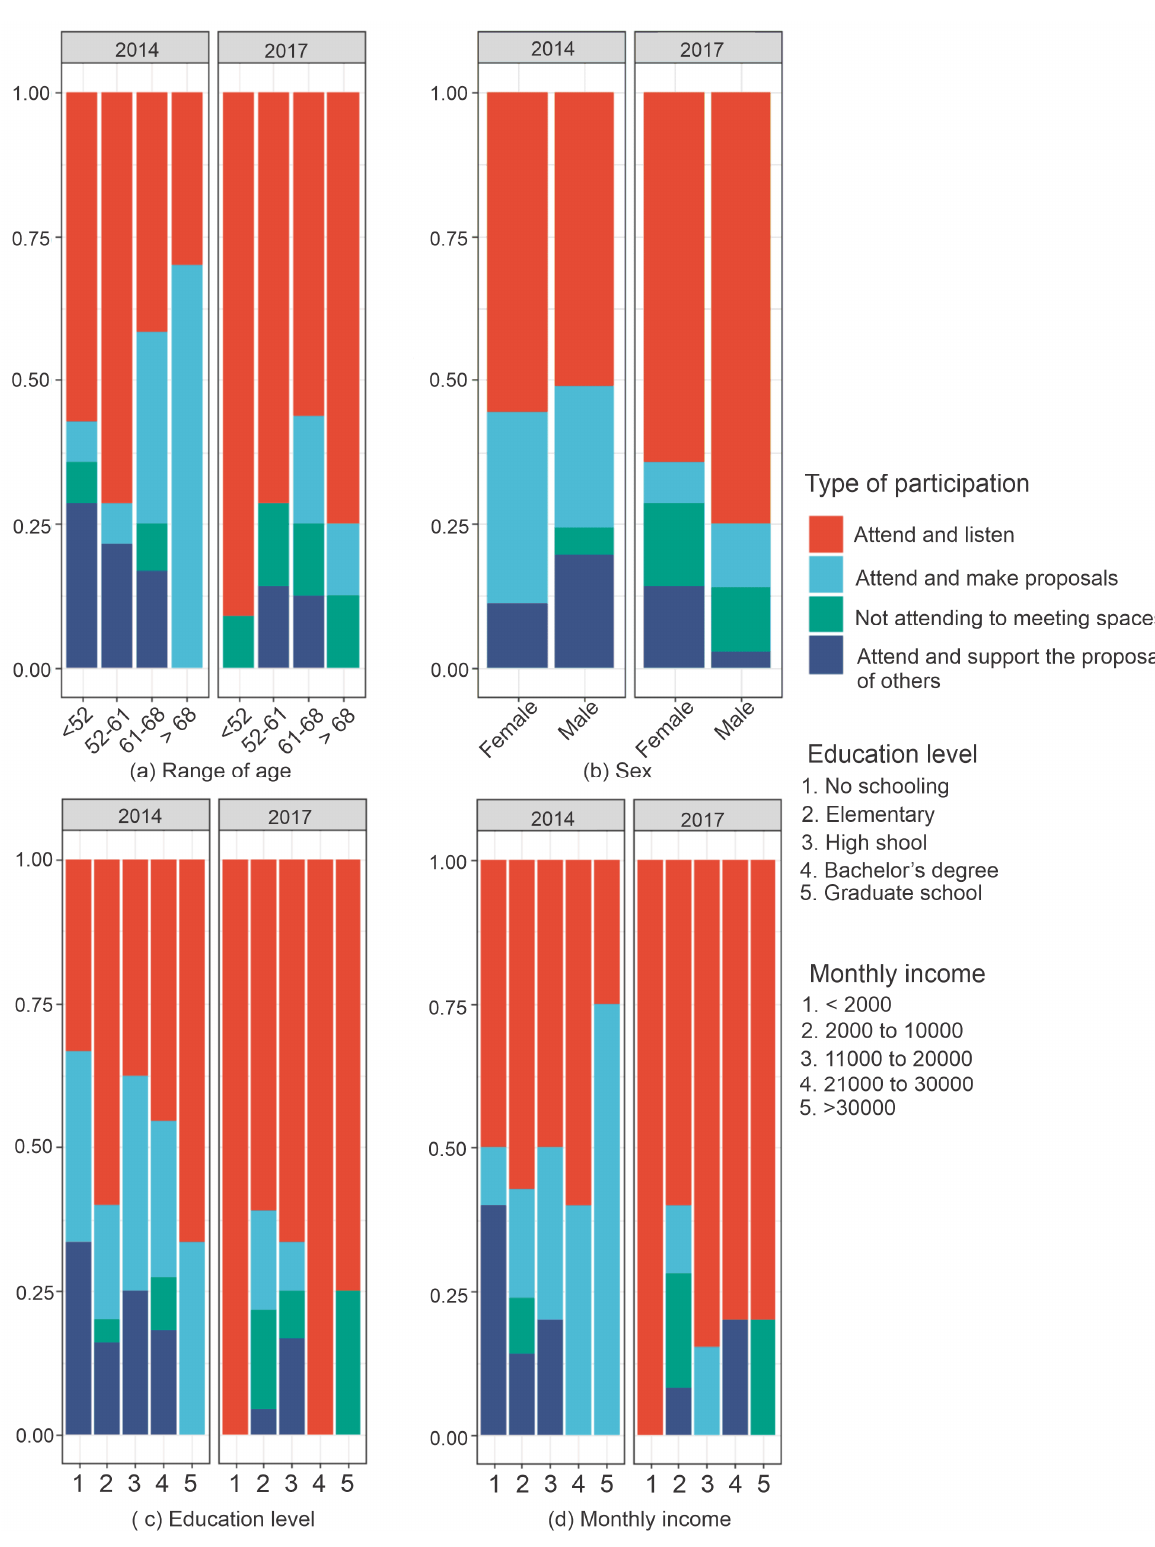
Figure 3. Types of participation by socioeconomic characteristics and survey application period: ( a ) fractions of responses by range of age; ( b ) fraction of responses by gender; ( c ) fraction of responses by level of schooling; ( d ) fraction of responses by categories of reported monthly